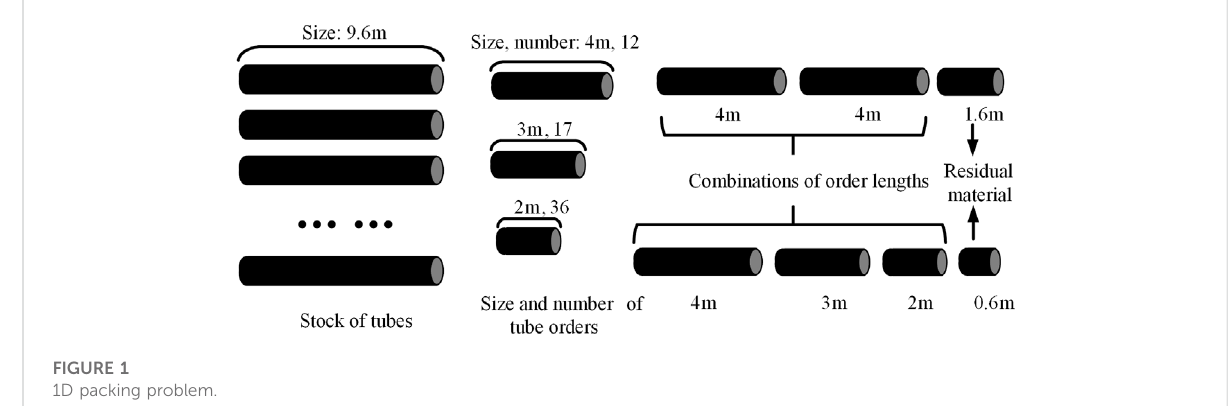
FIGURE 1 1D packing problem.